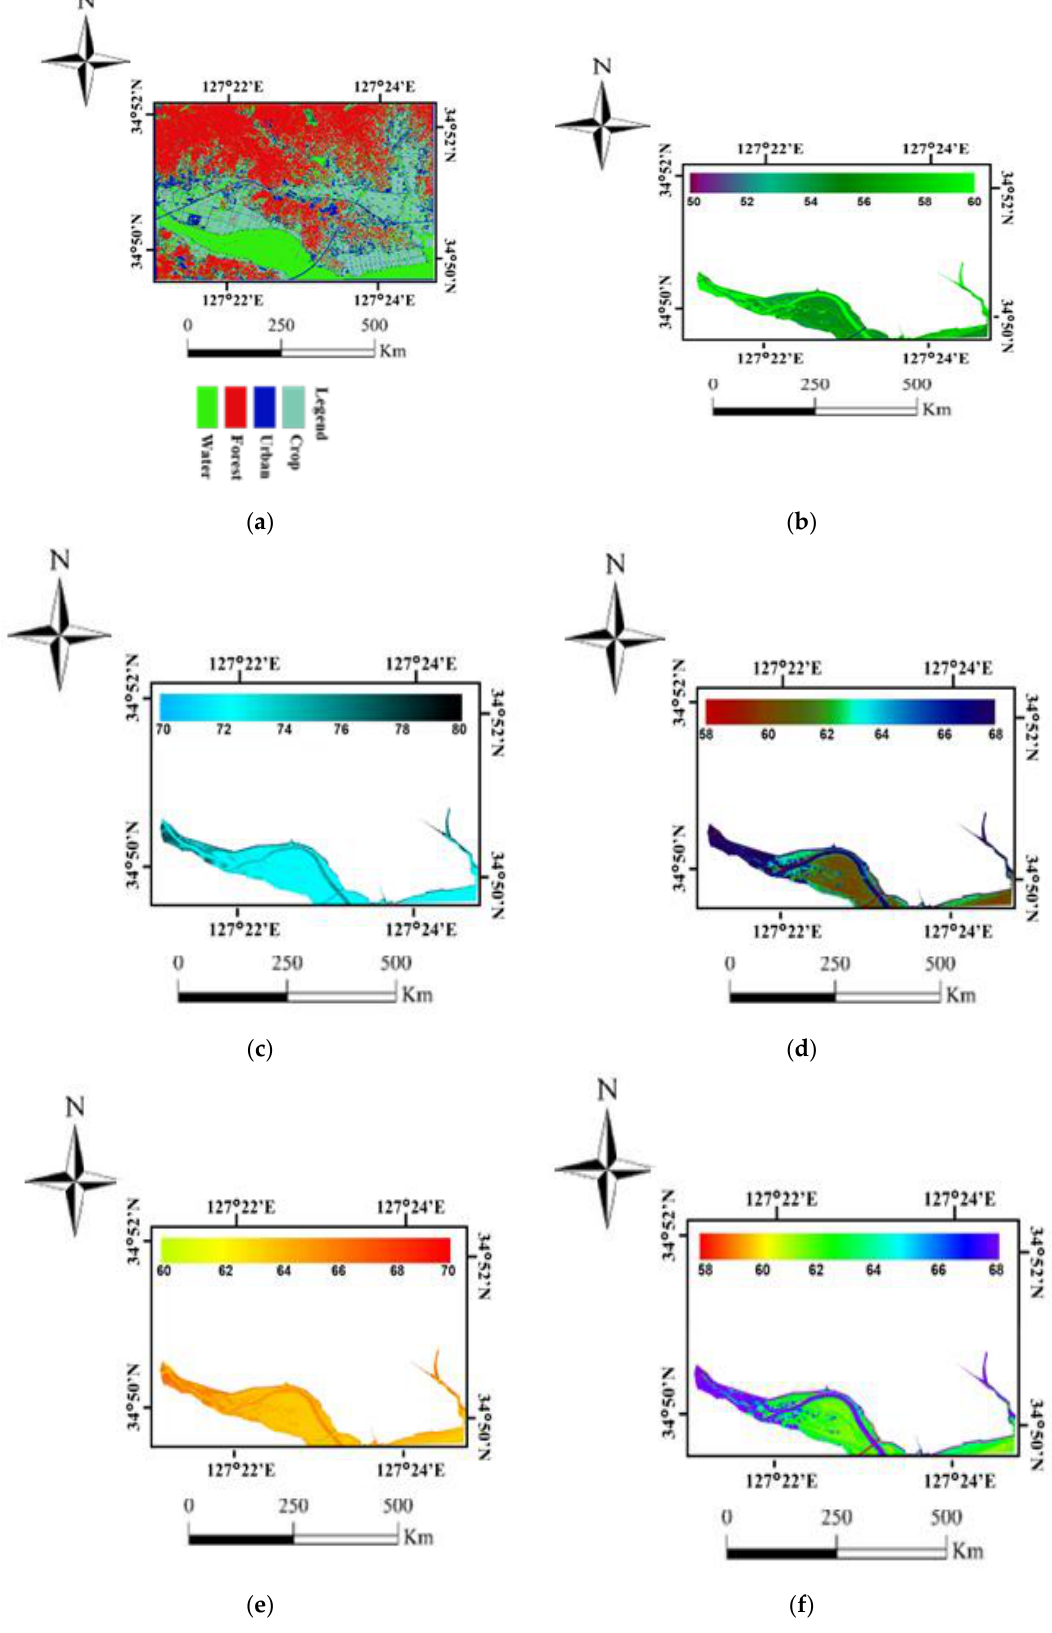
Figure 2. ( a ) Land-use Land-cover classification map, ( b ) TSI of Chl-a, ( c ) TSI of SDT, ( d ) TSI of TP, ( e ) TSI of TN, and ( f ) Overall